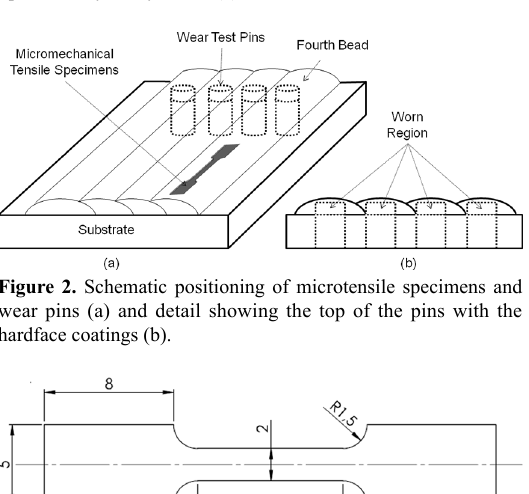
Figure 1. Schematic showing coated area: (a) Positioning of Spectrometry Analysis and (b) Microstructure and Hardness Tests.